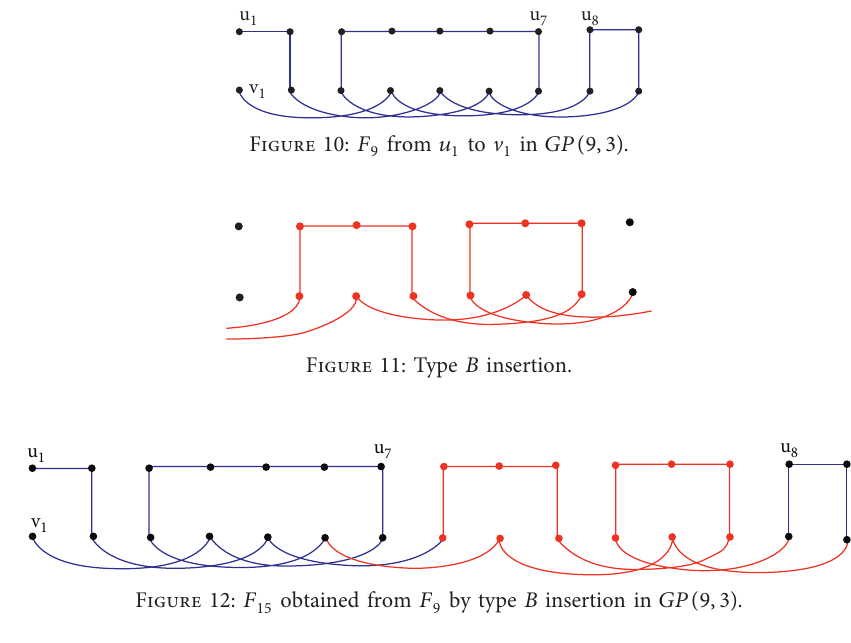
obtained from F 15